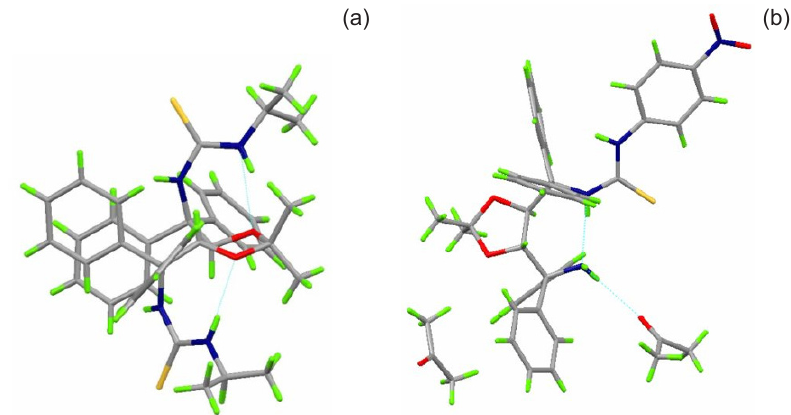
Figure 4. X-Ray structures of the ( S,S ) bis-thiourea H2 (left - 4a) and ( S,S ) amino-thiourea H7 (right – 4b) obtained from ( R,R )